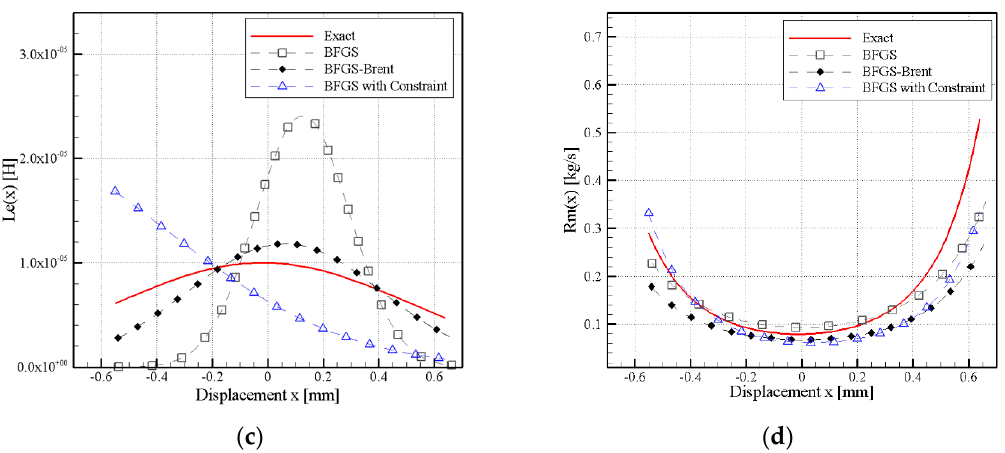
Figure 7. Effect of measurement error σ = 0.15 on nonlinear parameters, ( a ) Bl ( x ), ( b ) K m ( x ), ( c ) L e ( x ), and ( d ) R m ( x ).